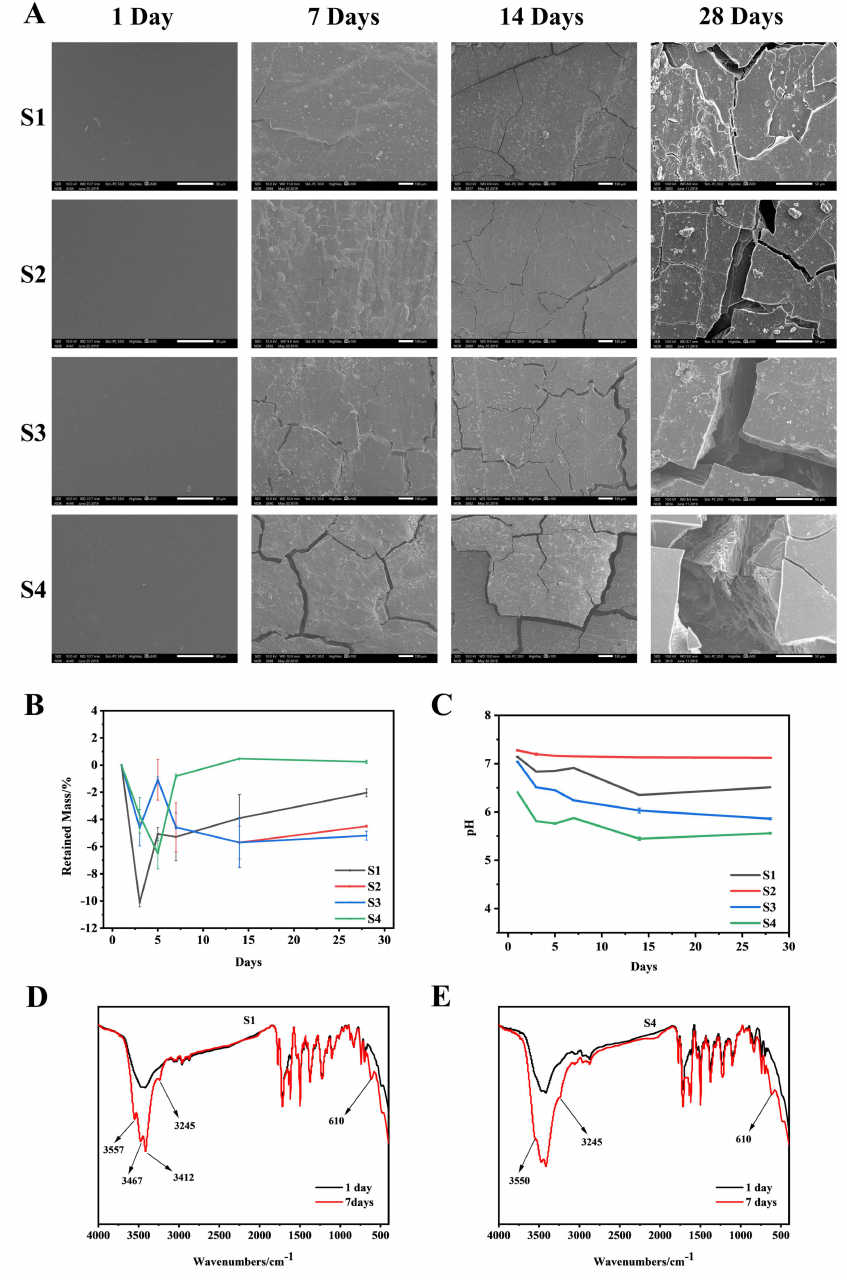
Figure 5. In vitro degradation experiment. ( A ): SEM surface morphology of S1–S4 degraded in PBS at 37 ◦ C for 1, 7, 14, and 28 days. ( B ): residual mass during S1–S4 degradation; ( C ): during S1–S4 degradation pH value of degradation solution; ( D ): Infrared characterization chart of S1 without degradation and degradation for 7 days; ( E ): Infrared characterization chart of S4 without degradation and degradation for 7